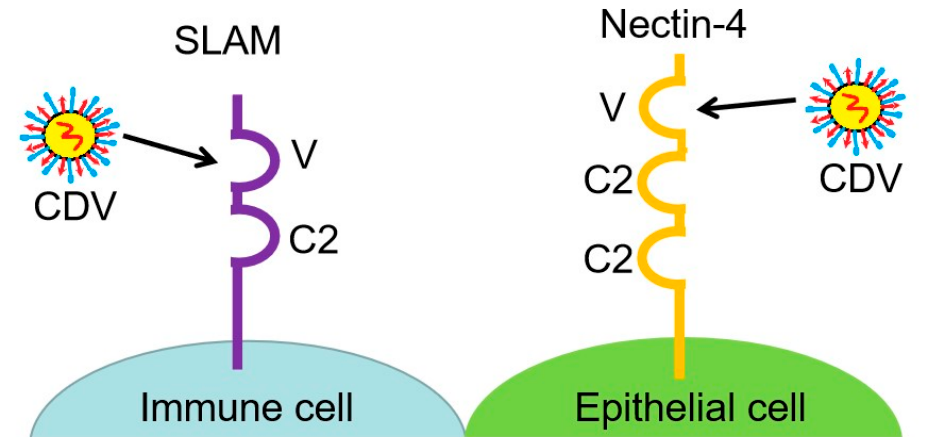
Figure 1. Interaction between canine distemper virus (CDV) and its immune and epithelial cell receptors, SLAM and nectin-4, respectively. CDV binds to the variable (V) domain of SLAM or nectin-4 on immune cells or epithelial cells,